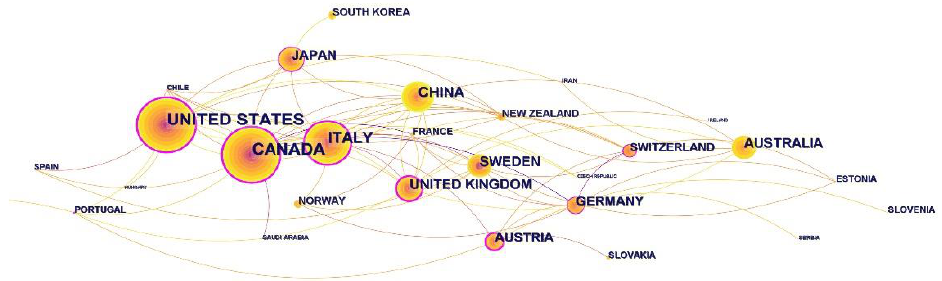
Figure 6. Network of countries/regions for publication of CLT in construction from 2006 to 2022.